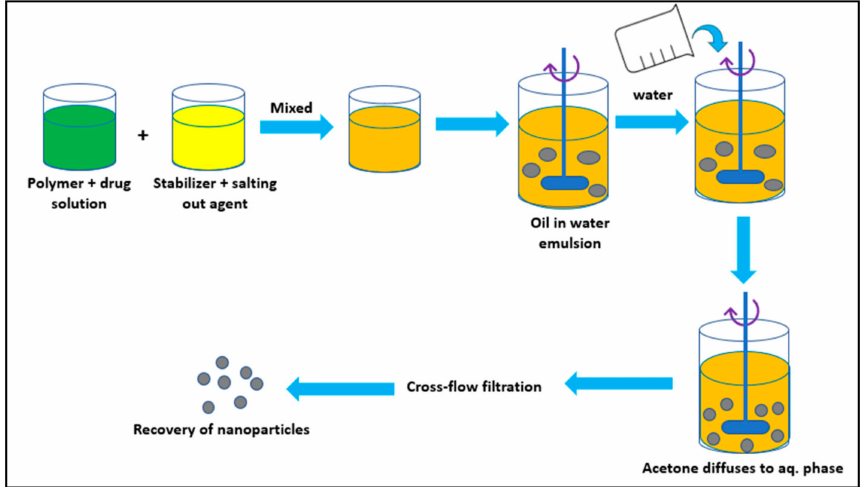
Figure 6. Salting out